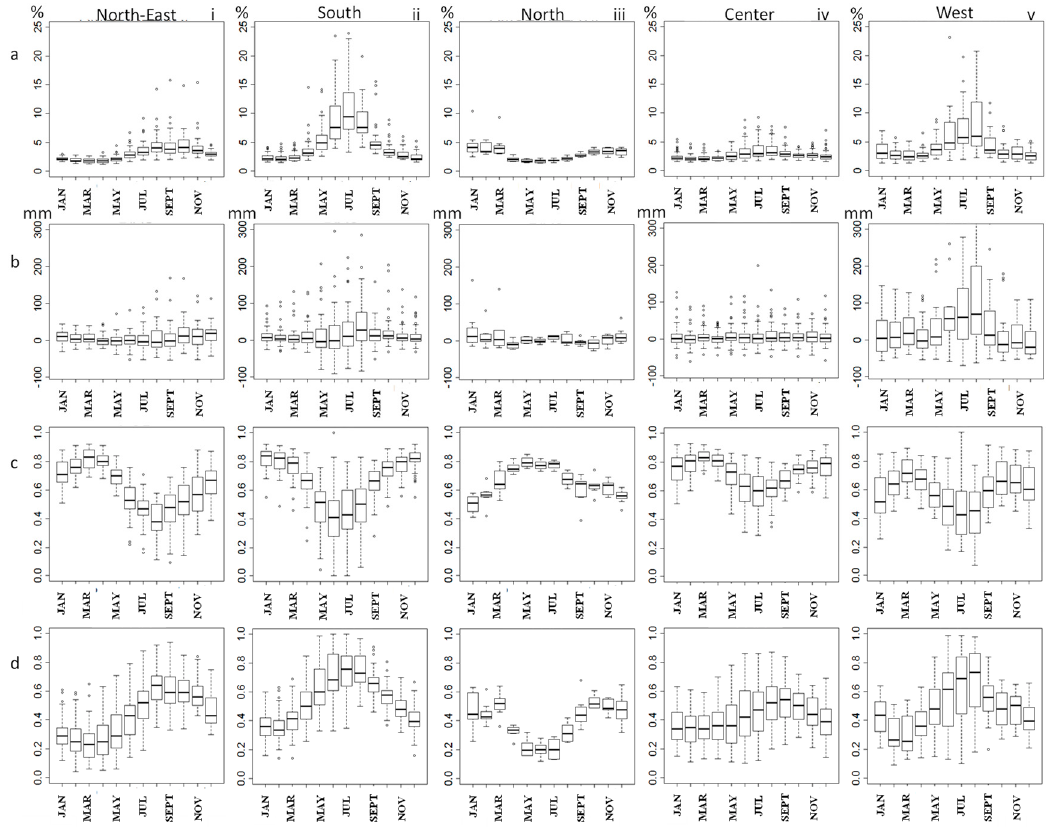
Figure 8. ( a ) Relative RMSE (in mm), ( b ) bias (in mm), ( c ) POD, and ( d ) FAR of 3B42, at daily scale for each month of the year for the five regions: ( i ) the northeast, ( ii ) south, ( iii ) north, ( iv ) center, ( v ) west regions.